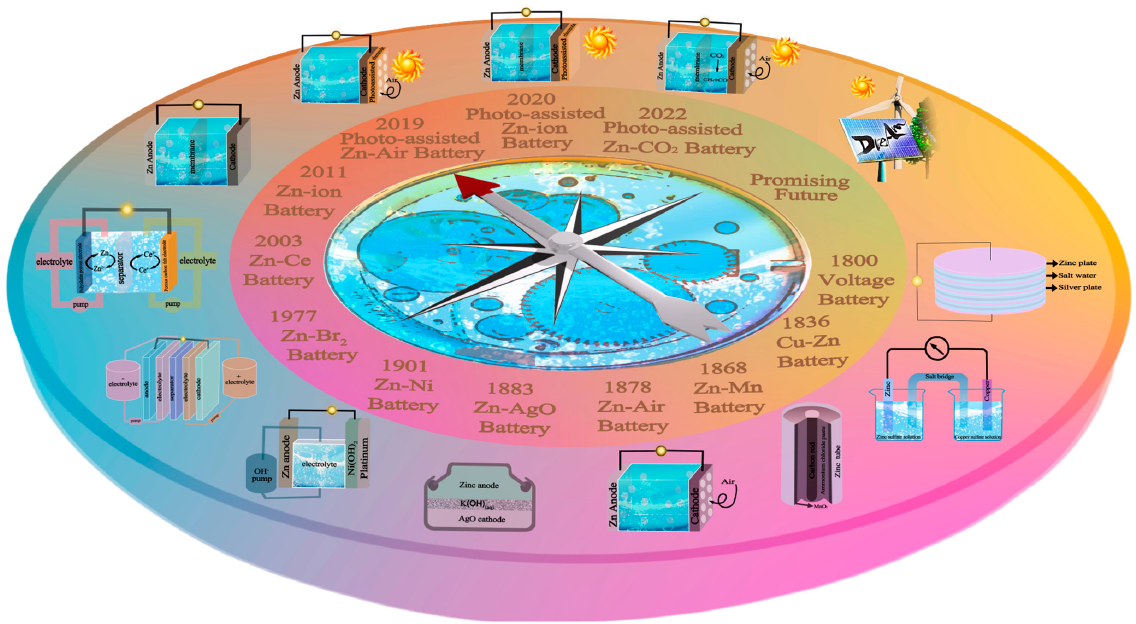
Figure 1. The development history of zinc-based ba tt eries.